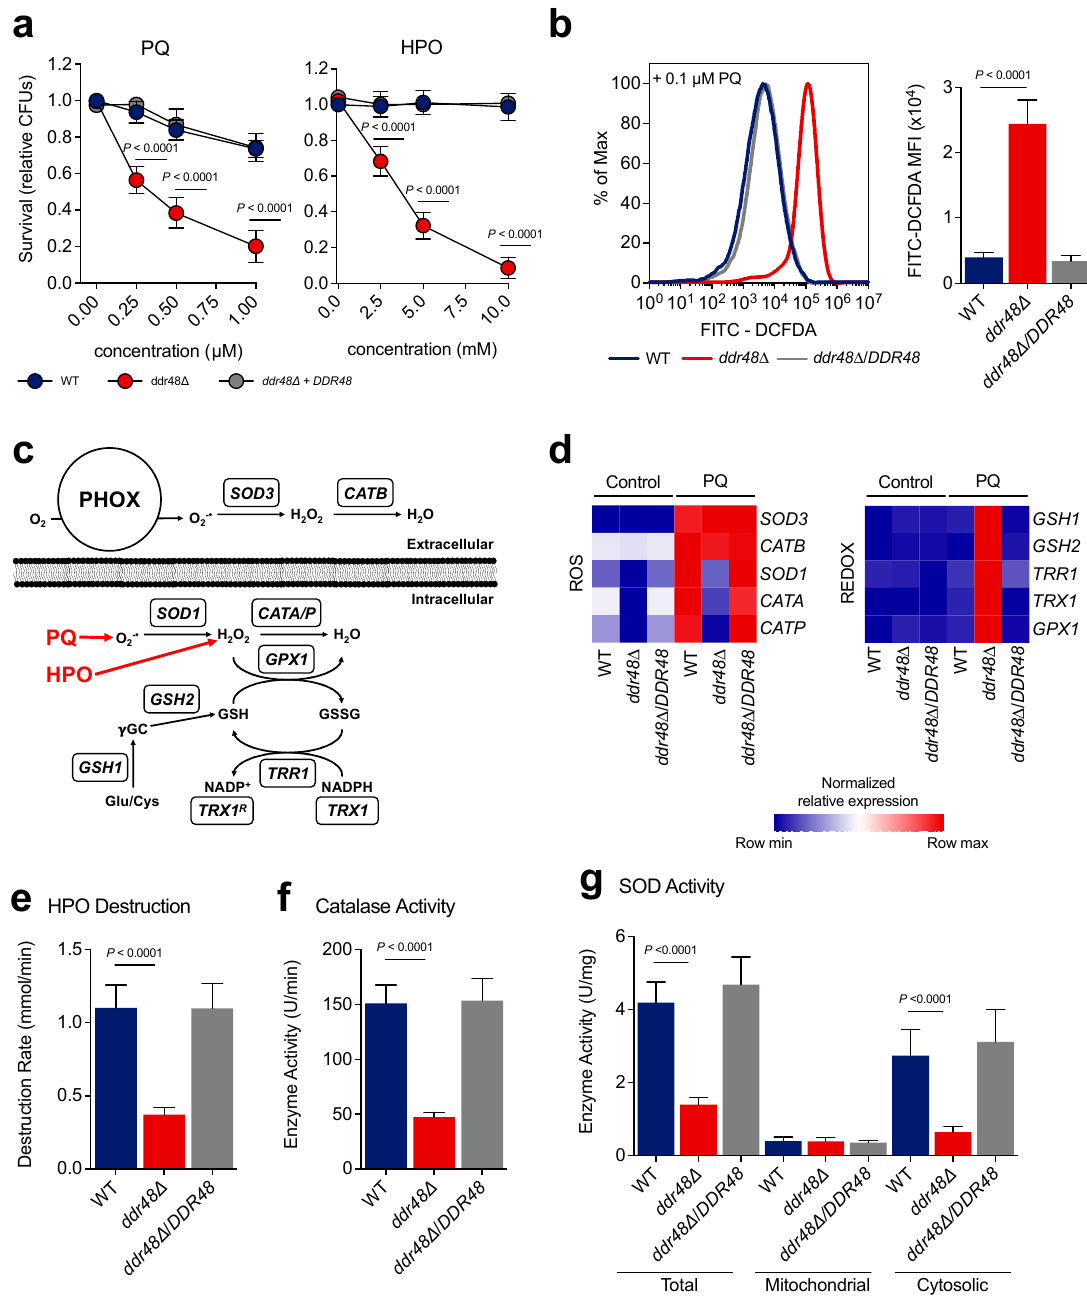
Figure 3. ddr48 ∆ yeasts possess decreased antioxidant activity, resulting in increased ROS levels and killing. ( a ) Survival (relative CFUs) of wildtype ( DDR48(+) ), ddr48 ∆ , and ddr48 ∆ /DDR48 strains measured ( n = 8) after 4 days of growth in